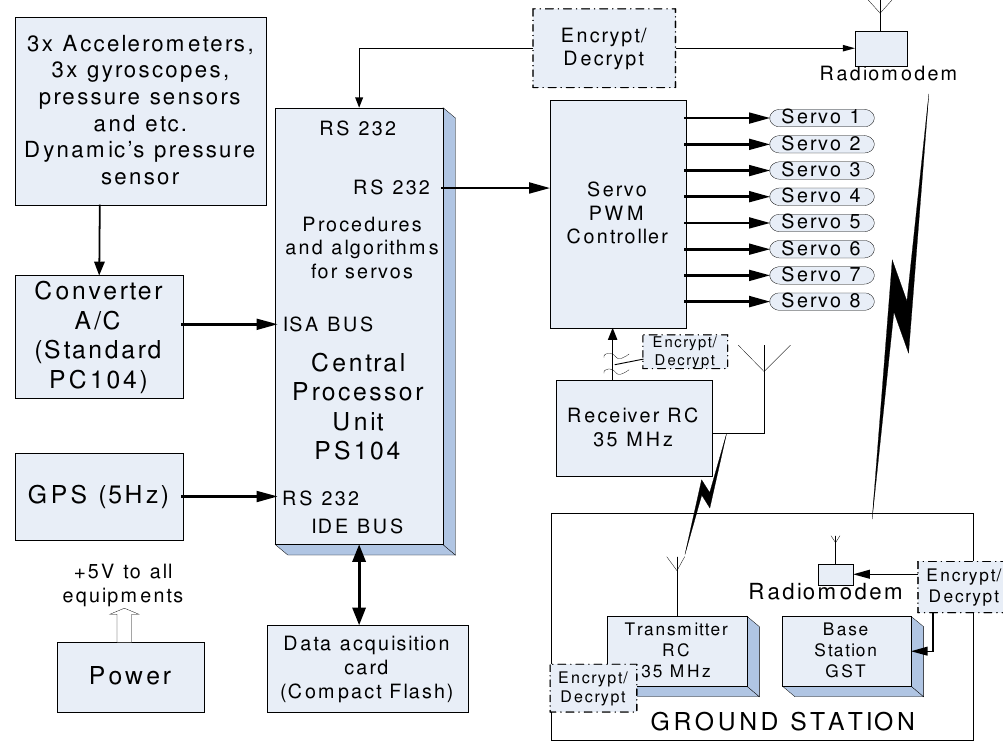
Fig 3. The functional diagram of SAMONIT radio communication system (Homziuk et al.